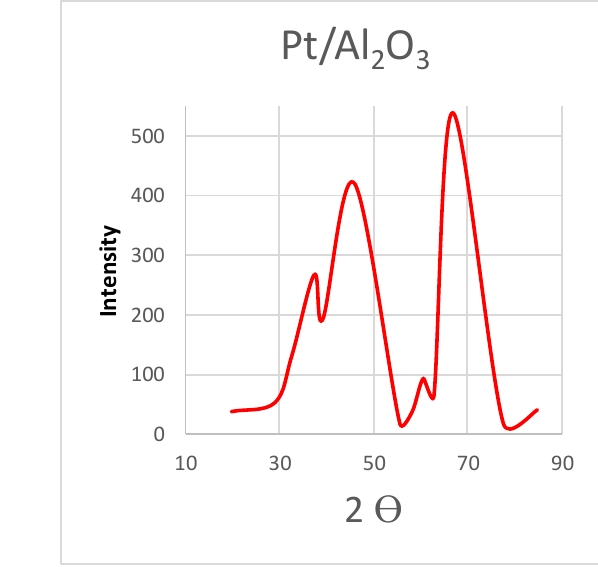
Figure 3: XRD pattern of Ni, Mo / Alumina catalyst. Figure 4: XRD pattern of Pt / Alumina